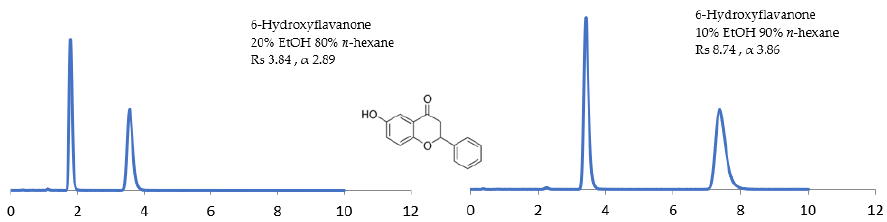
Figure 3. The effect of decreasing the alcohol percentage on chiral selectivity and time taken for the baseline separation of 6-hydroxyflavanone.